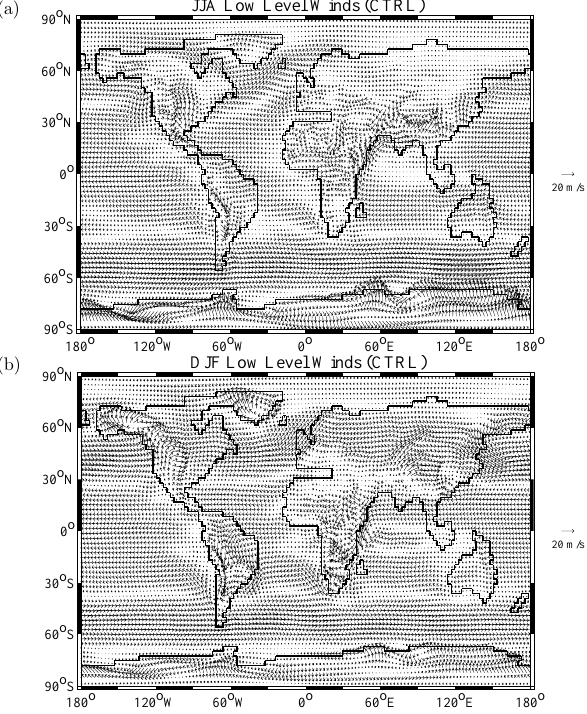
Fig. 10. Low-level winds (850hPa) for the CTRL experiment in (a) Northern Hemisphere summer and (b) Northern Hemisphere